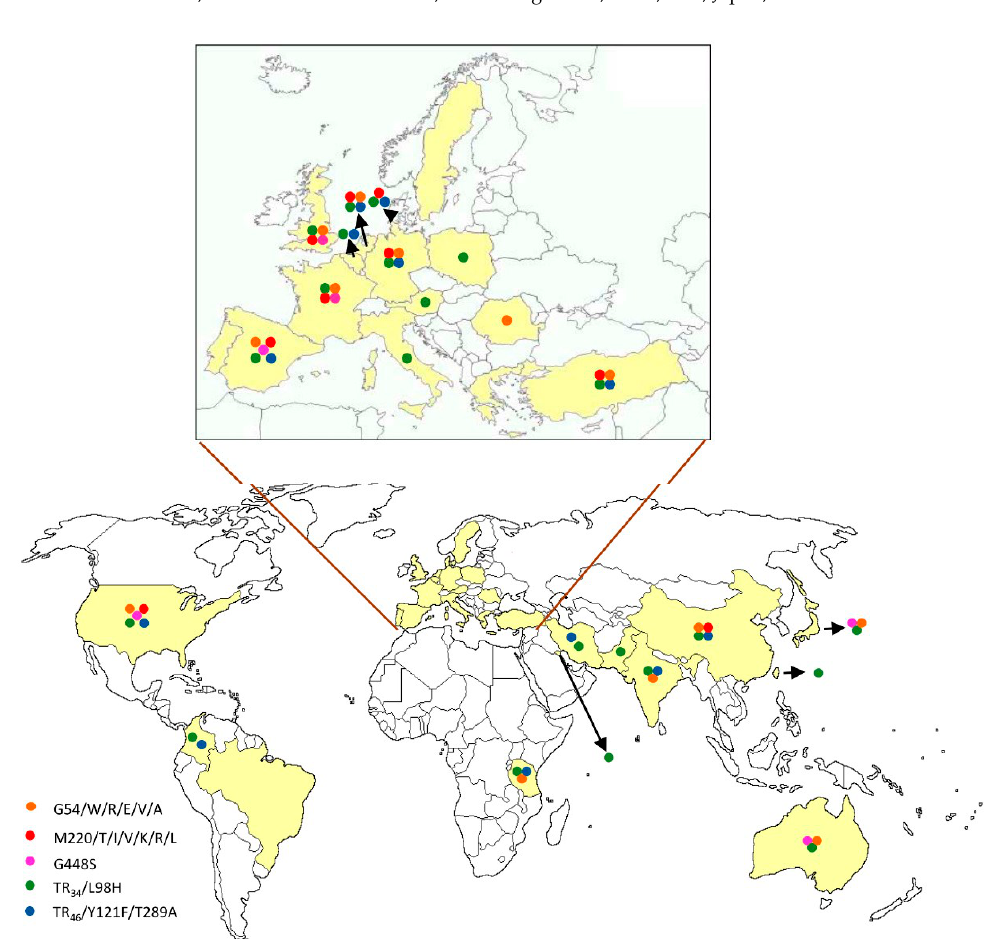
Figure 1. Worldwide distribution of azole resistance in A. fumigatus by mechanisms.